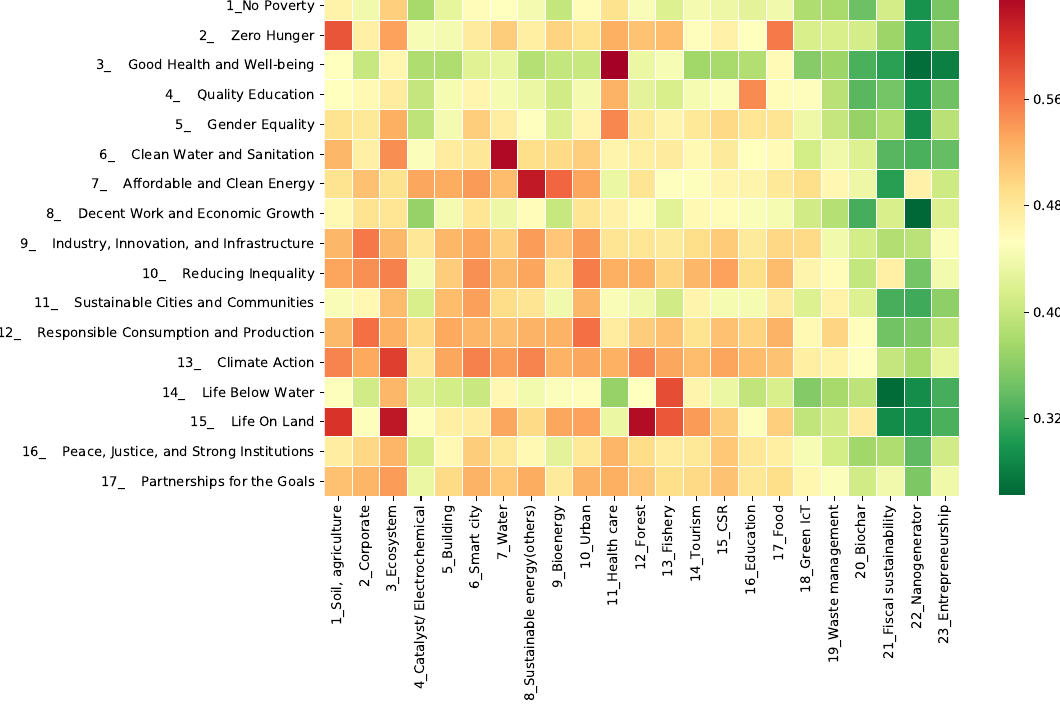
Figure 4. Heat map between SDGs and scientific